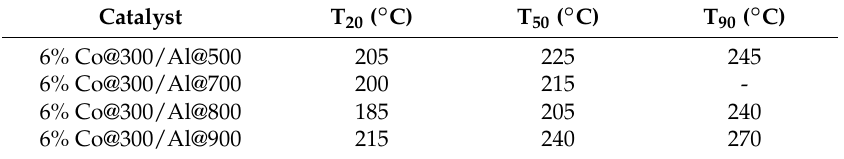
Table 2. Six percent Co/Al with @ = pre-calcination temperatures of the carrier for CO oxidation. Catalyst